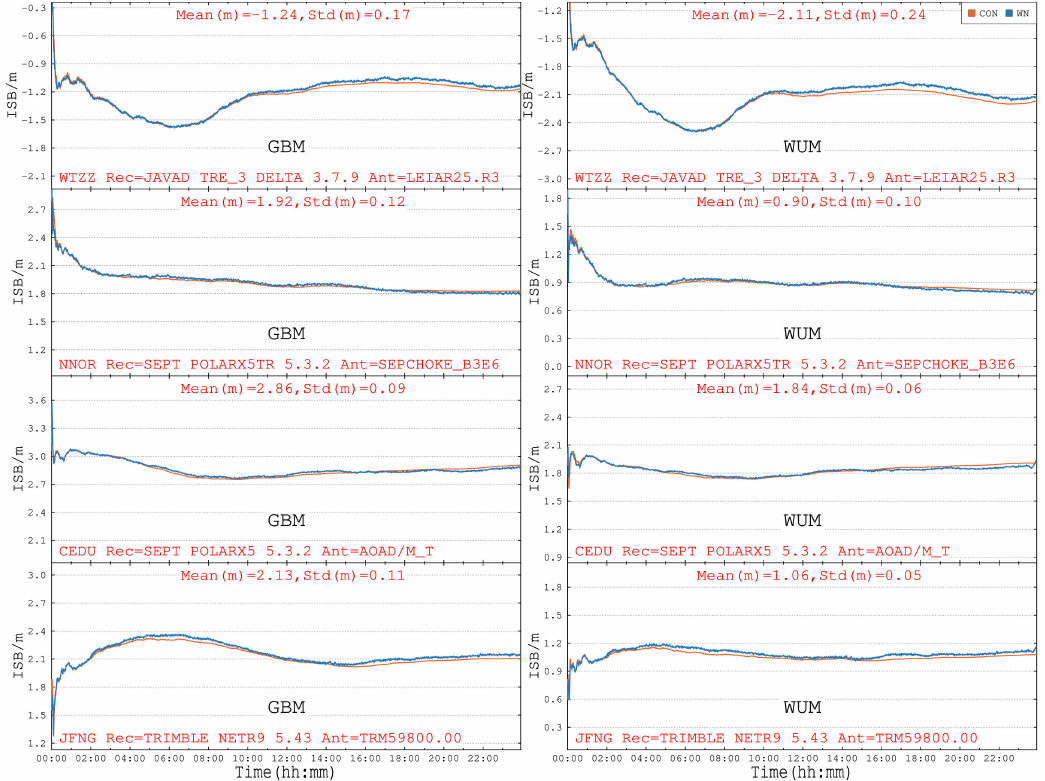
Figure 5. The time series of ISB for BDS-2 and BDS-3 by using GBM and Wuhan University (WUM) precise products at DOY 110,